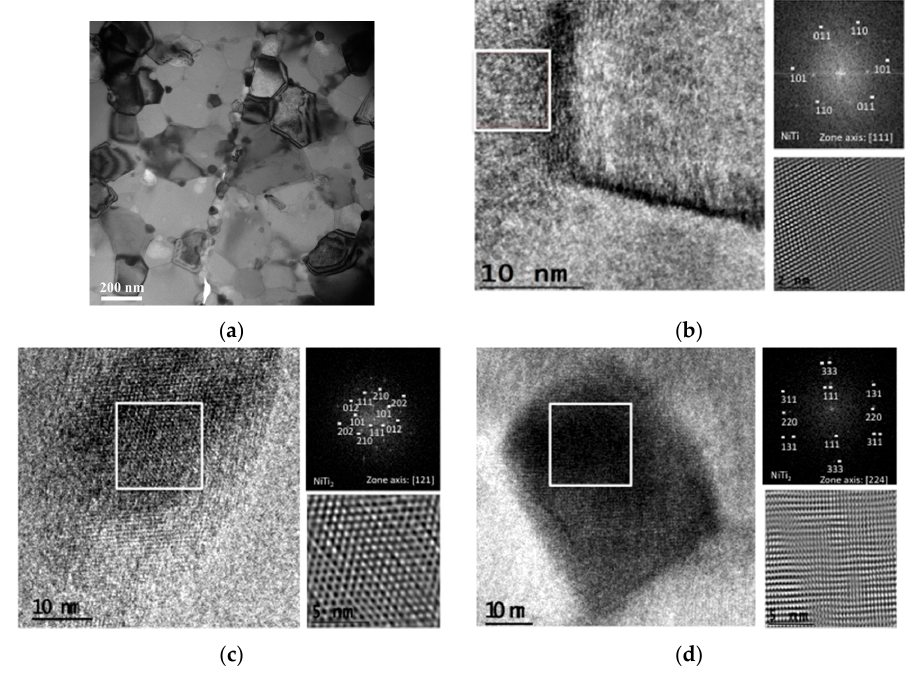
Figure 4. ( a ) TEM image of the interface central zone of a TiAl/steel joint produced at 800 °C using Ni/Ti multilayers with 30 nm of bilayer thickness; ( b ) and ( c ) HRTEM images and FFT indexation as NiTi and NiTi 2 grains at the center of the joint interface; and ( d ) HRTEM images and FFT indexation as NiTi 2 of a nanometric grain at the central line.